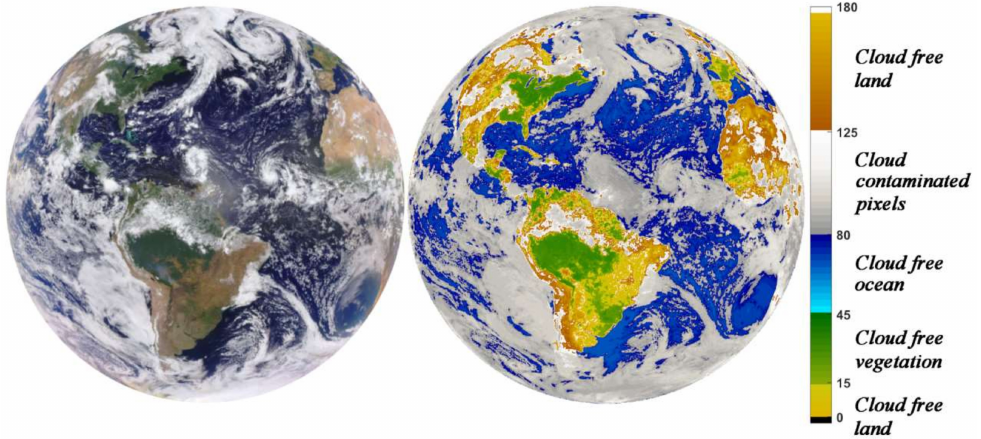
Figure 4. Left panel shows an EPIC RGB image taken on 23 August 2016 at 15:24:58 GMT. Equation (7) was applied to each image pixel. Right panel shows the distribution of ERTI over sunlit Earth. Its values corresponding to cloud-free ocean, land, vegetation, and cloudy pixels tend to occupy different spaces within the 0 ◦ to 180 ◦ interval. Phase angle is 5.65 ◦ . Color bar shows thresholds for different reflector